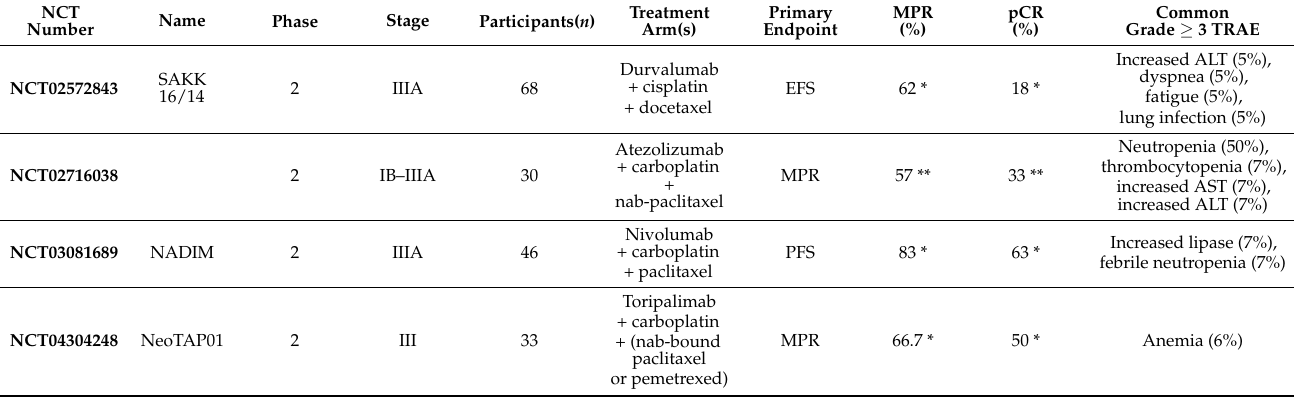
Table 2. Past clinical trials that included neoadjuvant chemoimmunotherapy in resectable